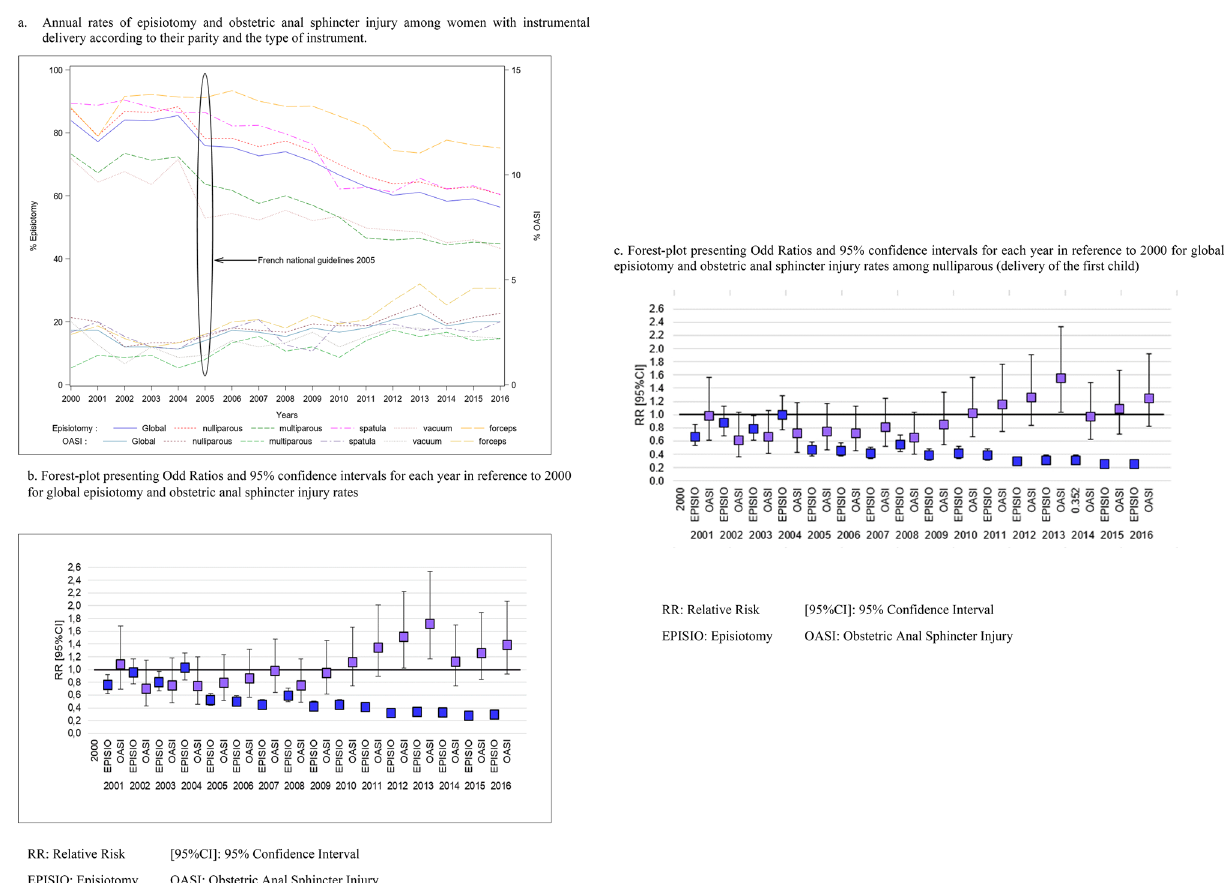
Figure 2. Impact of 2005 French national guidelines on the episiotomy and obstetric anal sphincter injury